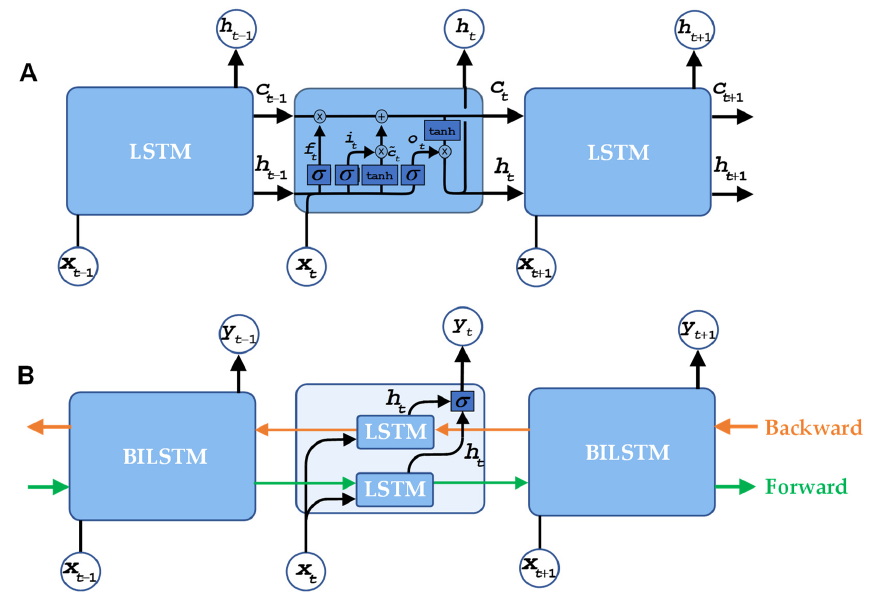
Figure 6. Comparison of a unidirectional LSTM cell with a bidirectional cell. ( A ) Unidirectional LSTM cell (LSTM). ( B ) Bidirectional LSTM cell (BiLSTM). For the detector based on a LSTM network, a neuronal network with 9 layers and 8 connections was developed (see Figure 7).